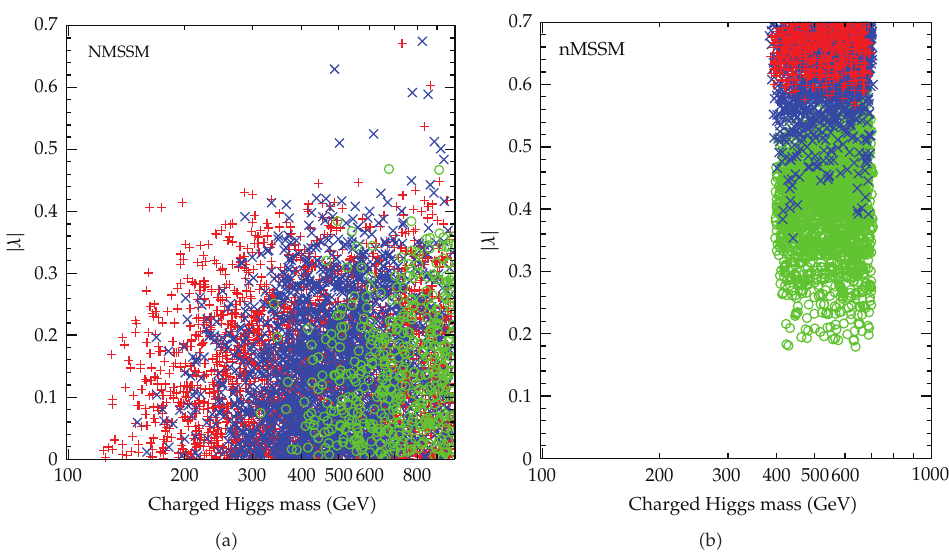
Figure 4: Same as Figure 1, but projected on the plane of | λ | versus the charged Higgs mass in the NMSSM and the nMSSM (cid:2) taken for (cid:5) 46 (cid:6)(cid:3) .